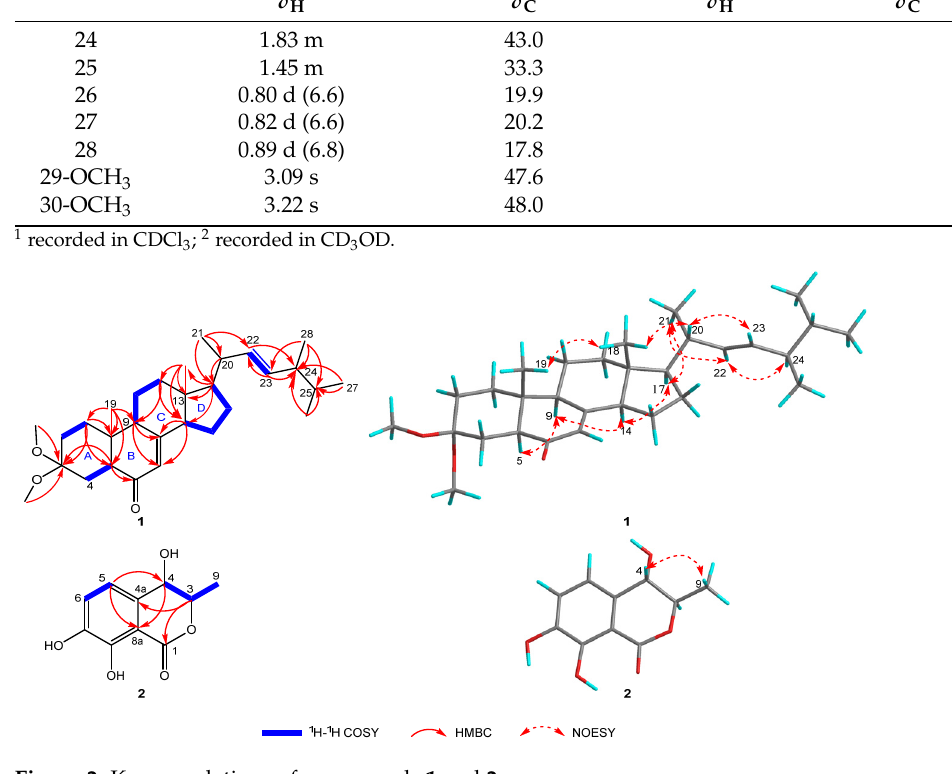
Figure 2. Key correlations of compounds 1 and 2 .